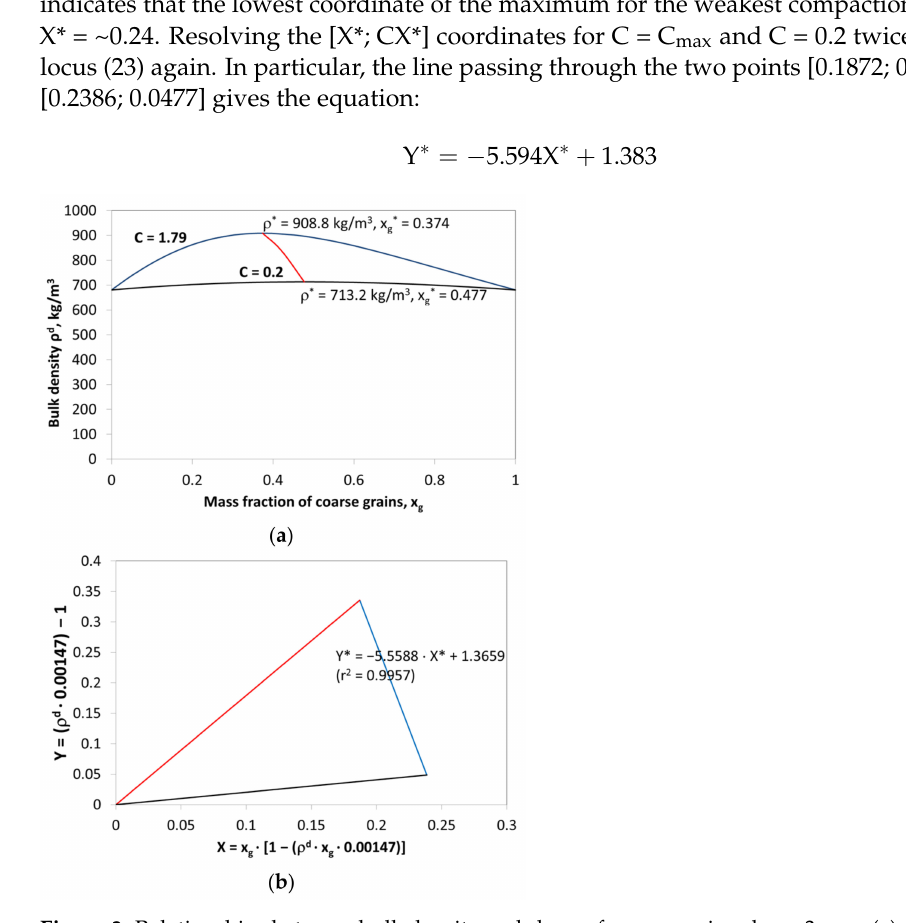
Figure 3. Relationships between bulk density and share of coarse grains above 3 mm: ( a ) dependence in Cartesian coordinate system for C = 0.2 (black), C = 1.79 (red), and locus (23) (blue); ( b ) transfor- mation acc. (15) from the locus (blue) for two C values as in Figure 3a. Table 3. Variation range of coarse grains share, 0 ≤ x g ≤ πρ o